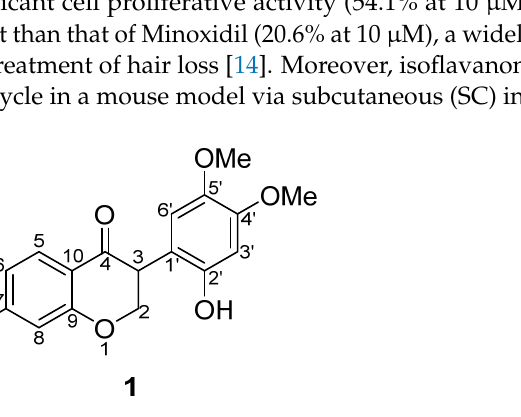
Figure 1. Chemical structure of 7,2 ′ -dihydroxy-4 ′ ,5 ′ -dimethoxyisoflavanone ( 1 ).